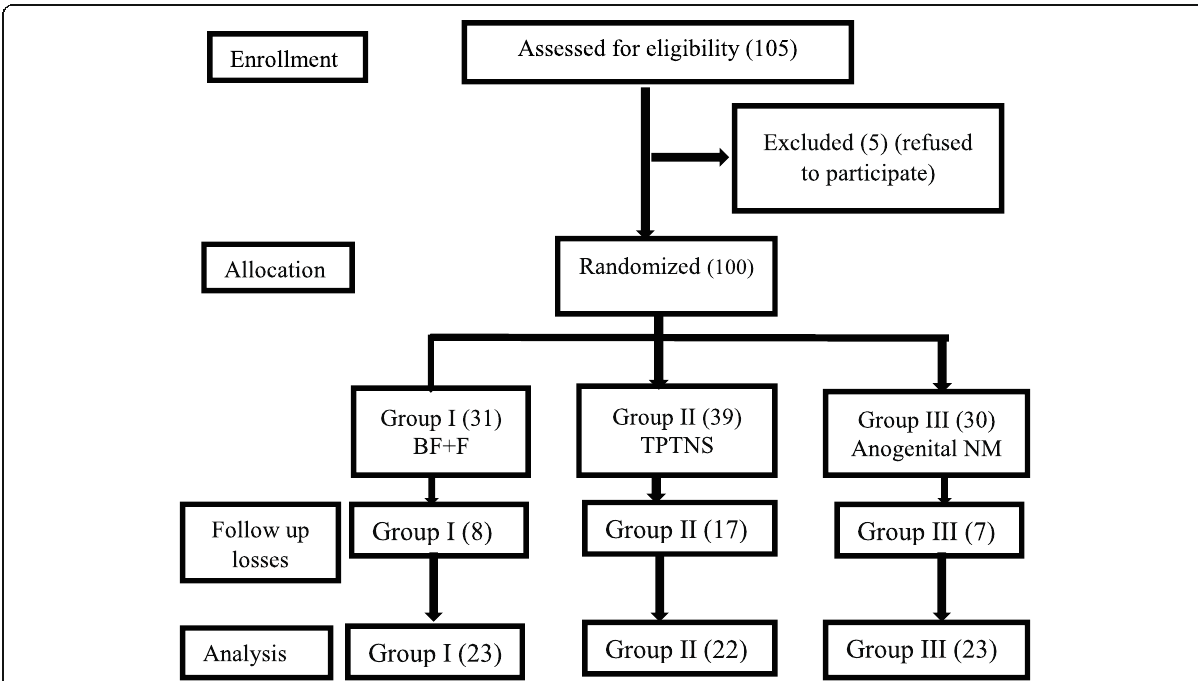
Fig. 1 Flow chart of the participants. BF, biofeedback with electrical stimulation; F, faradic stimulation, TPTNM, transcutaneous posterior tibial nerve stimulation; NM,